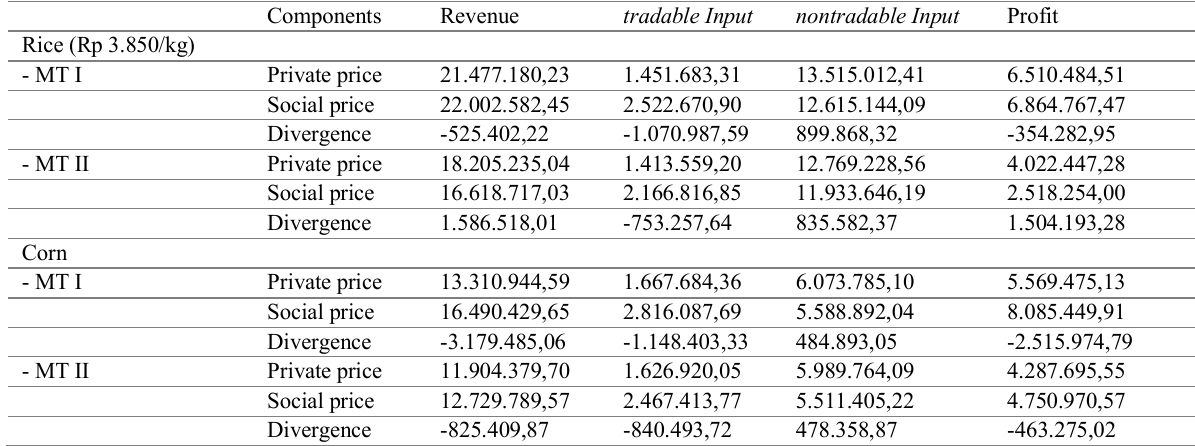
Table 9: PAM of Rice and Corn